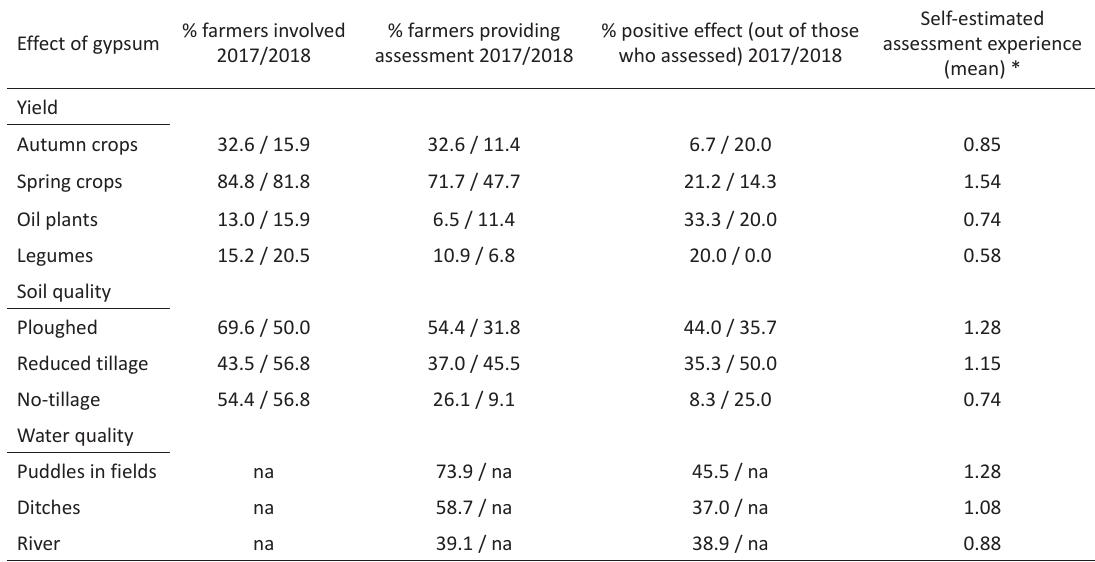
Table 2. Farmers’ observations of effects of gypsum amendment on yield, soil and water quality (2017: n=46, 2018: n=43)